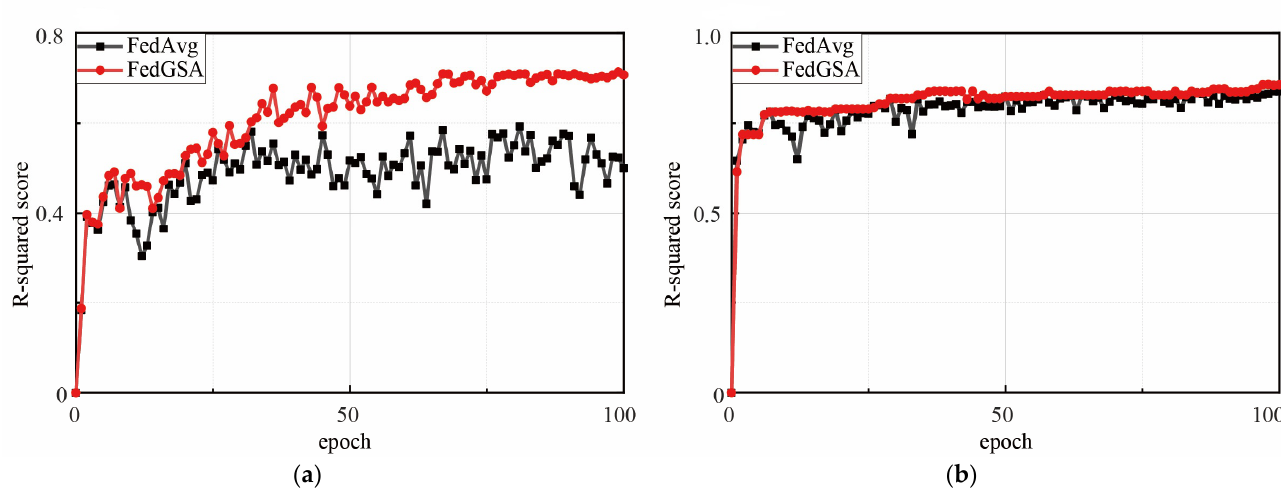
Figure 8. ( a ) Prediction accuracy and communication rounds on the Trento dataset. ( b ) Prediction accuracy and communication rounds on the Milano dataset.